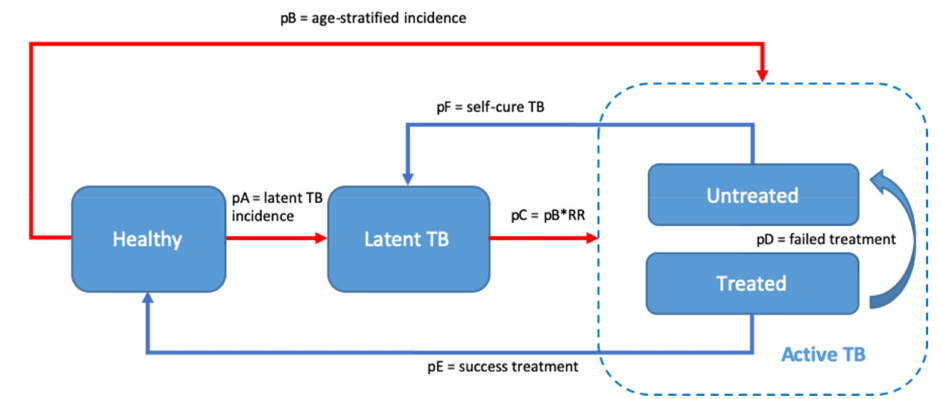
Figure 1. A model depicting the natural course of tuberculosis (TB). This model was based on the age-stratified incidence of TB and implicitly included the mortality rate at every stage. The red line is a ff ected by the vaccine e ff ectiveness. pA = probability of infection reflected as latent TB incidence, pB = probability of fast activation reflected as age-stratified active TB incidence, pC = probability of slow progression calculated by multiplying TB incidence with relative risk (RR) of developing TB disease in latent TB population, pD = probability of treatment failure, pE = probability of successful treatment, pF = probability of self-cure. Detailed transition probabilities were described in Table